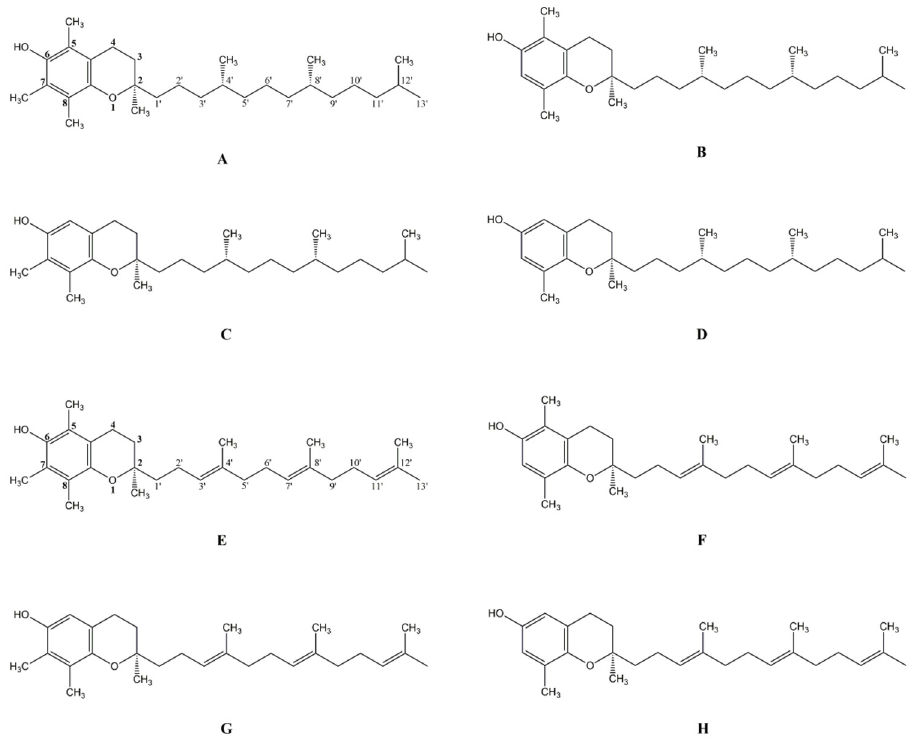
Figure 1. Naturally occurring tocopherols ( A – D ) and tocotrienols ( E – H ): α -tocopherol ( A ); β - tocopherol ( B ); γ -tocopherol ( C ); δ -tocopherol ( D ); α -tocotrienol ( E ); β -tocotrienol ( F ); γ -tocotrienol ( G ); δ -tocotrienol ( H